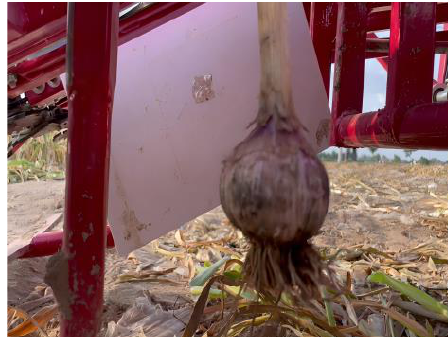
Figure 4. Image acquisition by the